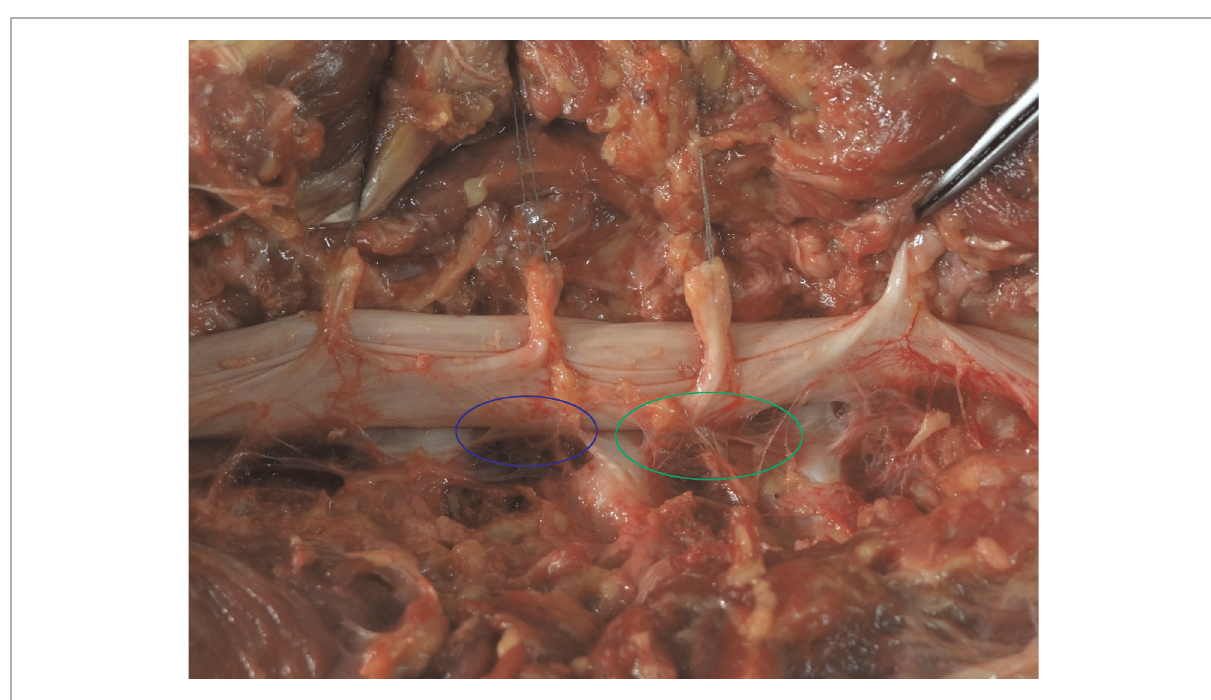
FIGURE 1 Presentationofthemedial(blue)andlateral(green)meningovertebralligaments.Spinalnervesaretransectedandelevatedforbetterpresentationpurposes.